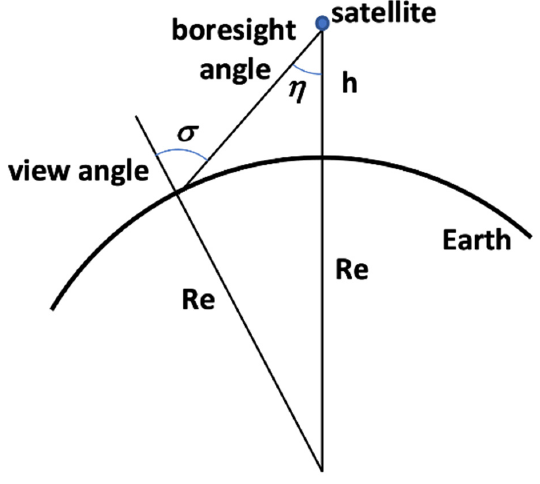
Figure 4. Geometrical relation between view angle and on-board off-nadir boresight angle. The camera arrangement in Error! Reference source not found. guarantees that all the NASA-JPL MISR view angles fall within the view angles reached by HORUS, as also schematically shown in Error! Reference source not found. (not to scale)., Error! Refer- ence source not found. indicates the off-nadir boresight angles obtained at various orbital heights, corresponding to 𝜎 (cid:3404) 70.5° . All of them are within the HORUS camera system total off-nadir field of view of ±66.8 degrees. Table 2. Off-nadir angles corresponding to the view angle of 70.5° at various orbital heights.